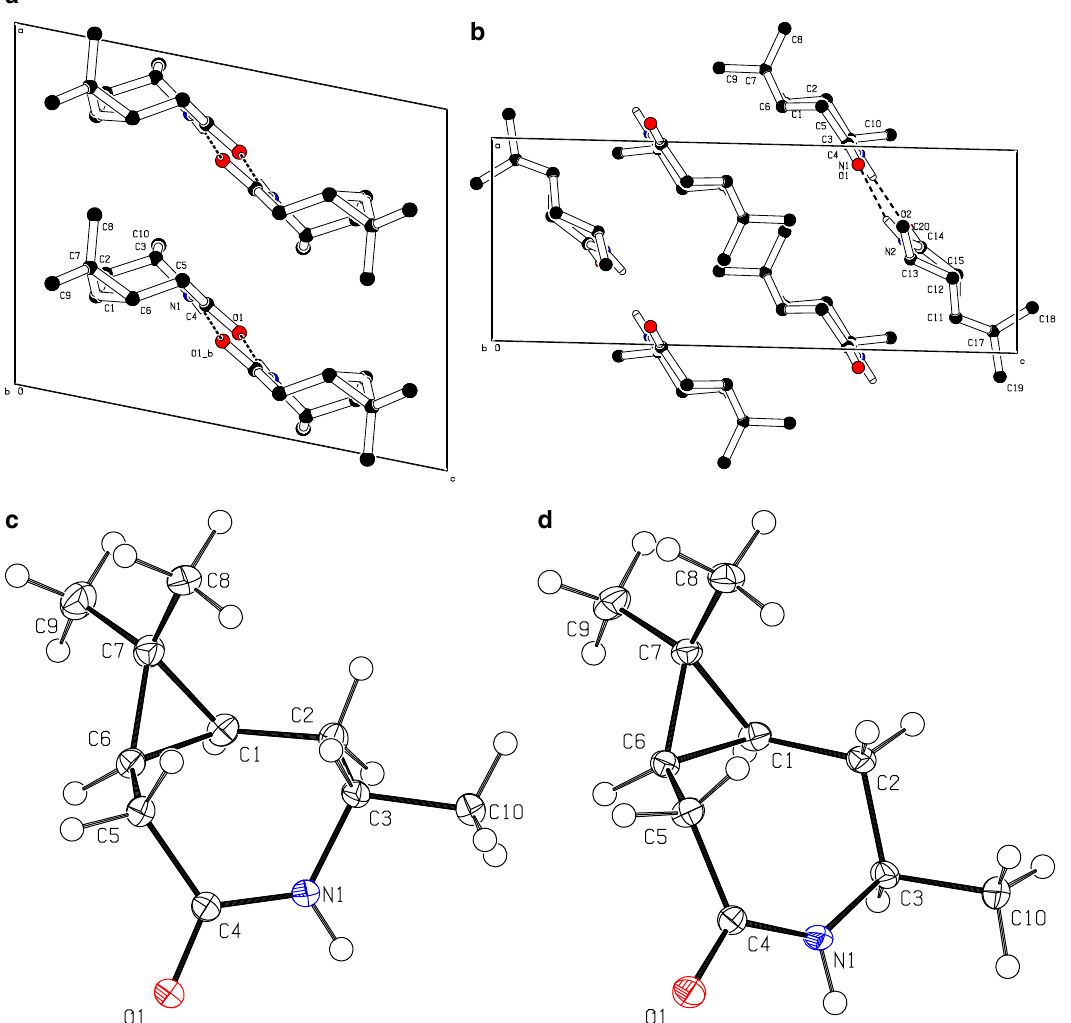
Fig. 9 Crystal structures of the monomers. Crystal structures and monomer molecule conformations of each 5-3R ( a, c ) and 5-3S ( b, d ) with bonding hydrogens only viewed in unit cell direction b